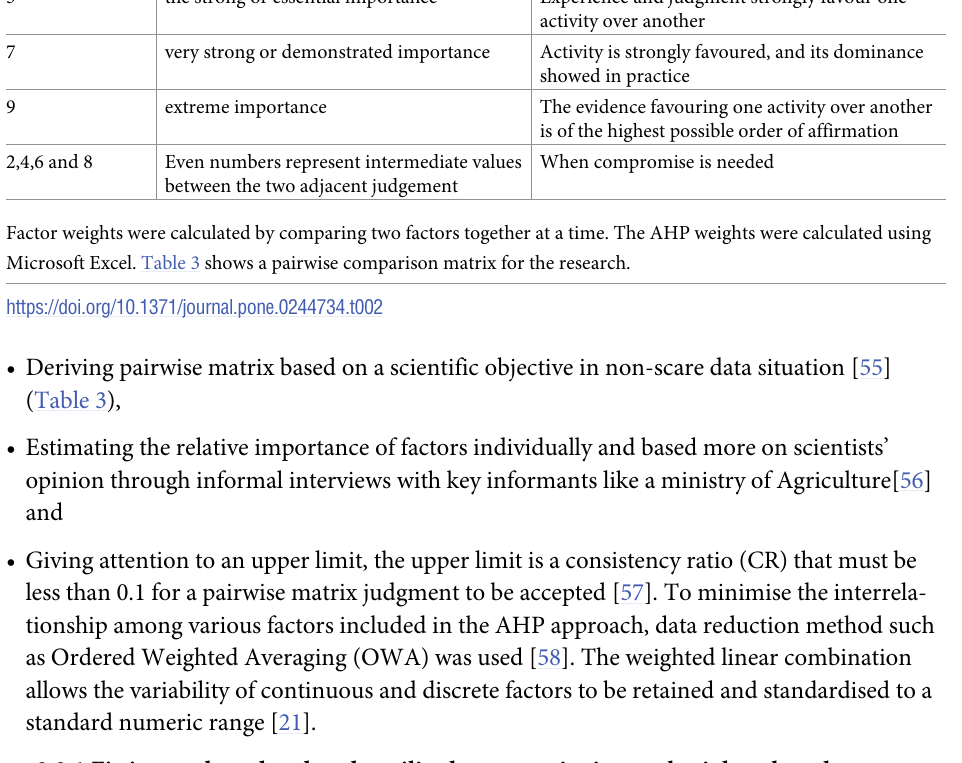
Table 2. The fundamentals for pairwise comparison [49].